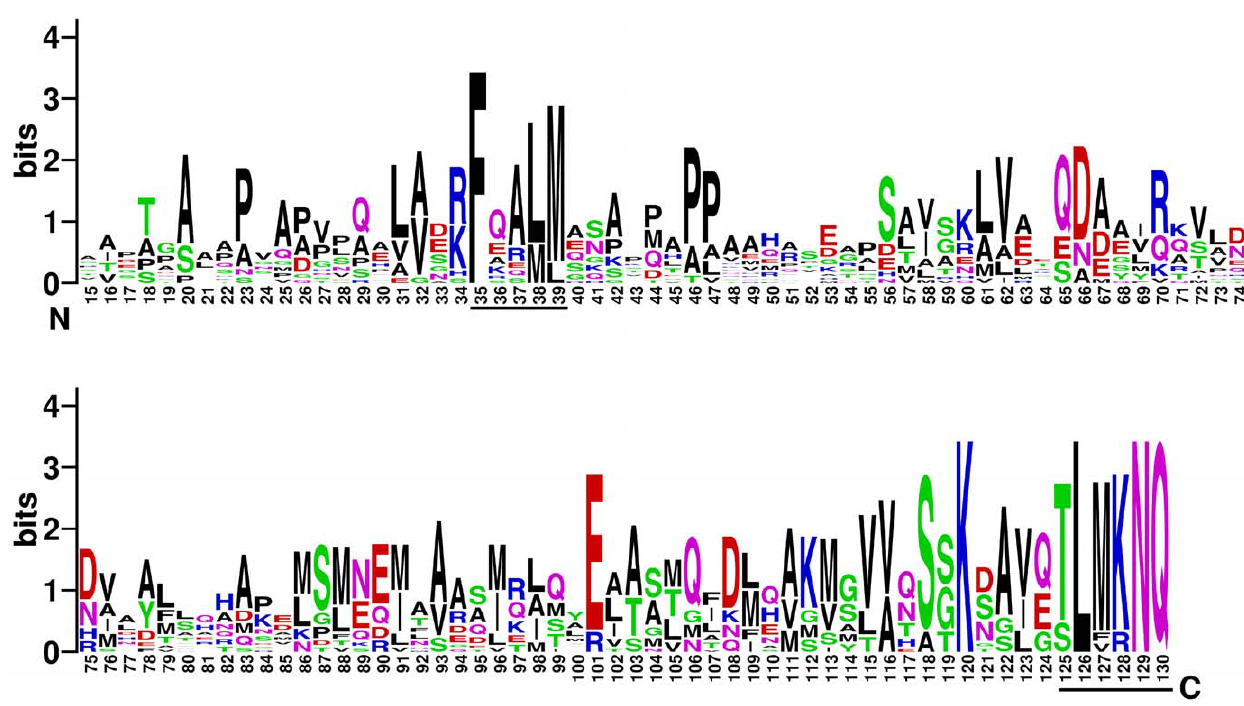
Figure 5. Graphical Representation of the multiple sequence alignment of the HrpB2 protein family. The Pfam database [64] lists 61 sequences in this group (PF09487) from Xanthomonas (13 sequences), Burkholderia (43 sequences), Ralstonia (3 sequences), and Acidovorax (2 sequences) species. However, after removal of all sequences with greater that 95% identity, only 16 remain. These 16 sequences were used to generate this representation using the WebLogo server (http://weblogo.berkeley.edu/) [65] in which the height of the residue symbol indicates the degree of conservation (the representation obtained using all 61 sequences is highly similar). Numbers refer to residue positions in HrpB2 XAC . The FQALM and TLMKNQ motifs are underlined.